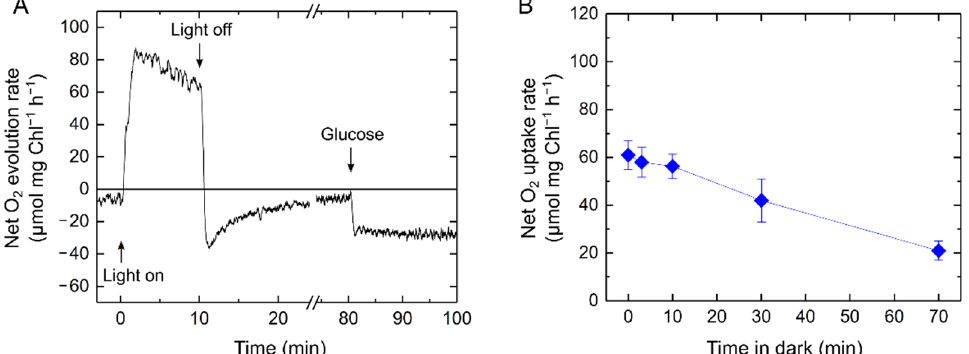
Figure 8. Relaxation of effects of exogenously added glucose on light-enhanced respiration (LER) in the darkness in Synechocystis sp. PCC 6803. The cyanobacterial cells adapted to darkness for 24 h (10 µ g Chl mL − 1 ) were illuminated with a red actinic light (190 µmol photons m − 2 s − 1 ) for 10 min. ( A ) Representative data of net O 2 evolution rate in response to the illumination with the actinic light and the addition of glucose (5 mM) as indicated by arrows. ( B ) Net O 2 uptake rate stimulated by the addition of glucose at different times after the actinic light was turned off. At time zero, glucose was exogenously added and then the O 2 uptake was measured just after the 10 min illumination with the actinic light. Data are shown as the mean with the standard deviation ( n = 3, biological repli- cates).